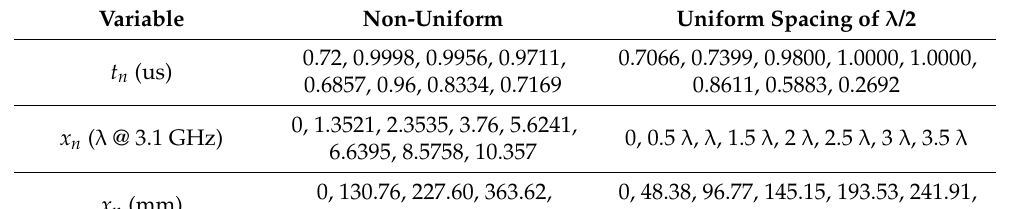
Table 2. Optimization Variables.